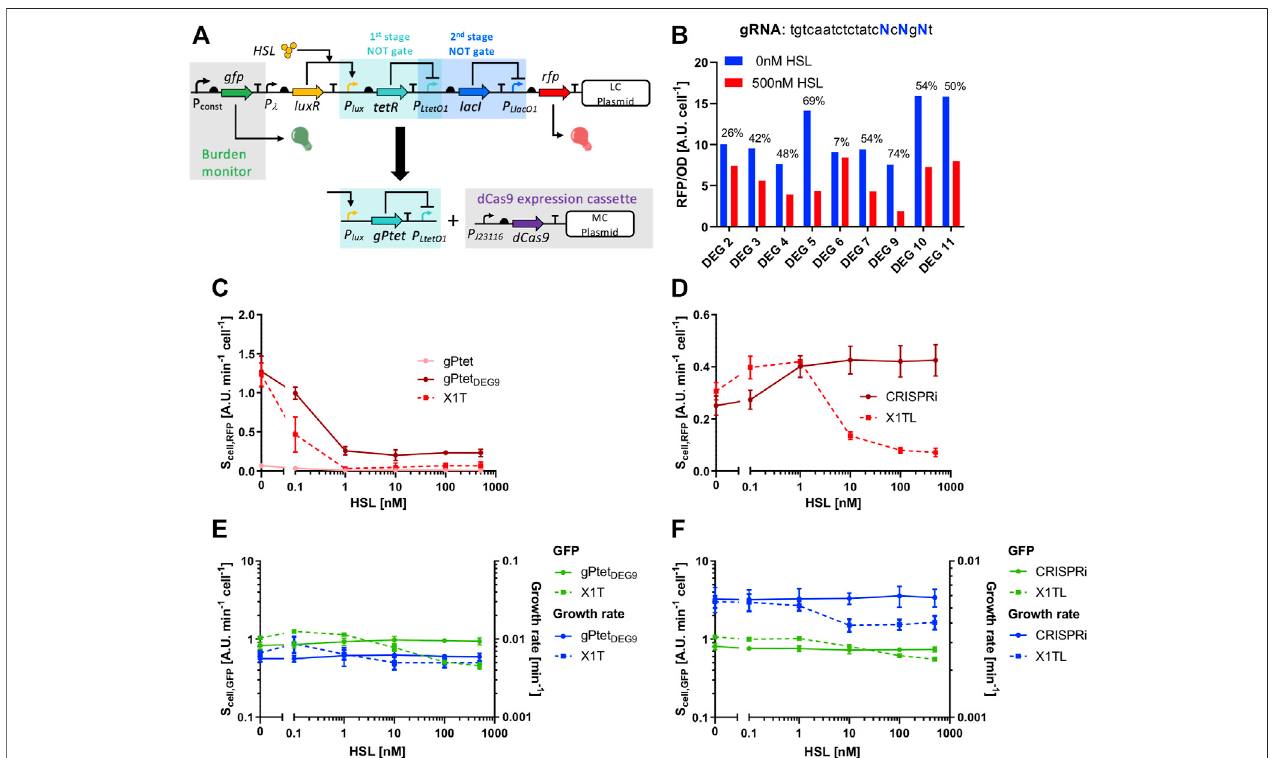
FIGURE 7 | Fixing of a non-functional transcriptional cascade. (A) Architecture of the non-functional cascade, including the LuxR, TetR and LacI regulators; it has HSL as input and RFP as output, and the main source of failure was the high resource usage of the tetR module, highlighted in light blue and indicated as the fi rst stage NOT gate. This module has been replaced with a CRISPRi logic inverter, including the parts illustrated below the black arrow. (B) Screening of nine degenerate gPtet guide variants without inducer or with 500 nM of HSL. The output is expressed as RFP/OD 600 . The numbers above the bars indicate the percent repression. (C) Characterization,intermsofRFPoutput,oftheindividualsingle-stageNOTgateswithP LtetO1 :X1TrepresentstheNOTgatewithTetR,gPtetindicatestheCRISPRiNOT gate withthe originalgPtet guide, and DEG9 indicates the CRISPRi NOTgate with the selected gPtet variant, gPtet DEG9 . (D) Characterization, in terms ofRFP output,of the full transcriptional cascades: X1TL represents the original circuit for which an unexpected non-monotonically increasing HSL-dependent output was reported, and CRISPRirepresentsthe fi xedcascadewiththegPtet DEG9 asrepressoroftheP LtetO1 promoter. (E,F) GFPandgrowthratevaluesforthesamestrainsillustratedinpanels (C,D) . In panels (C,D) , data are shown as the average RFP synthesis rate per cell; in panels (E,F) , data are shown as the average GFP synthesis rate per cell or average growth rate value. In panels (C – F) , data points represent the average value, with error bars representing the standard errors of the mean of at least three independent experiments.